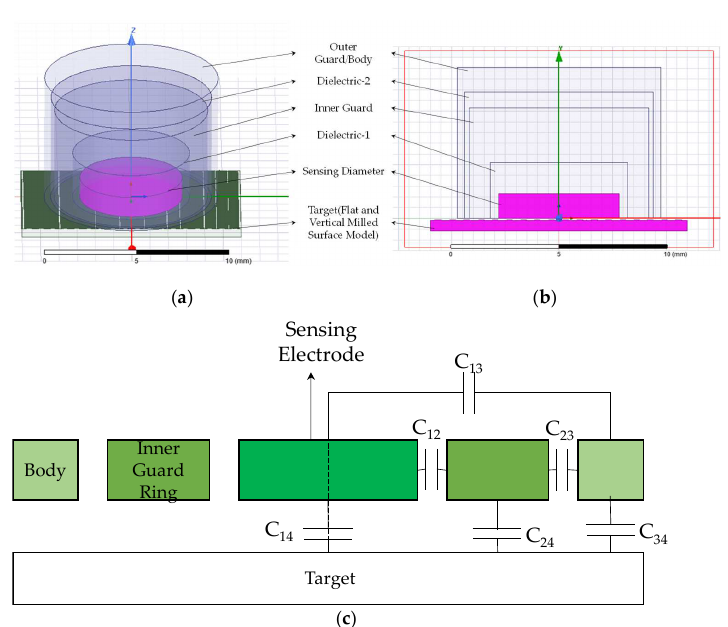
Figure 12. Sensor model: ( a ) 3D model of 5.6 mm capacitance sensor model with surface model; ( b ) 2D model of 5.6 mm capacitance sensor model with surface model ( c ); lumped capacitance between electrodes.